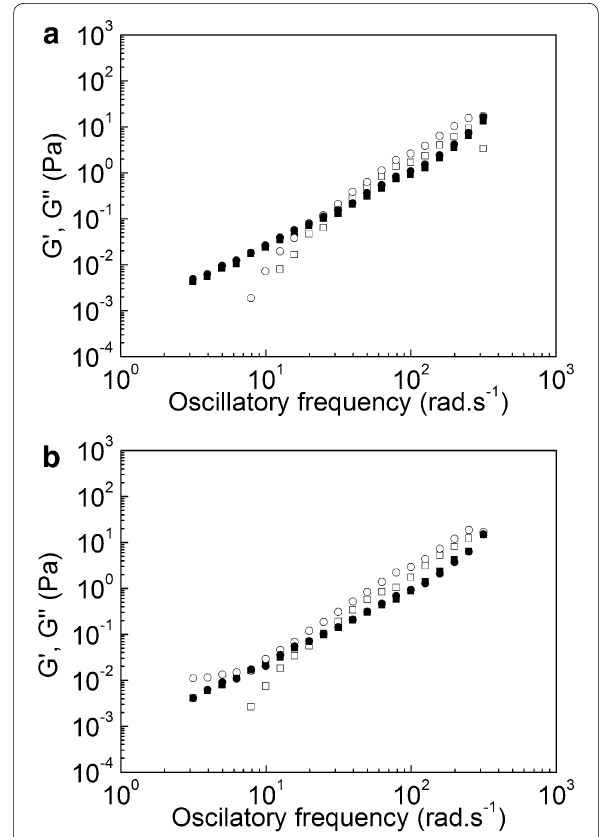
Fig. 5 Variation of storage and loss modulus values with oscillatory frequency for the solutions at 5 gL − 1 ( a ) and 10 gL − 1 ( b